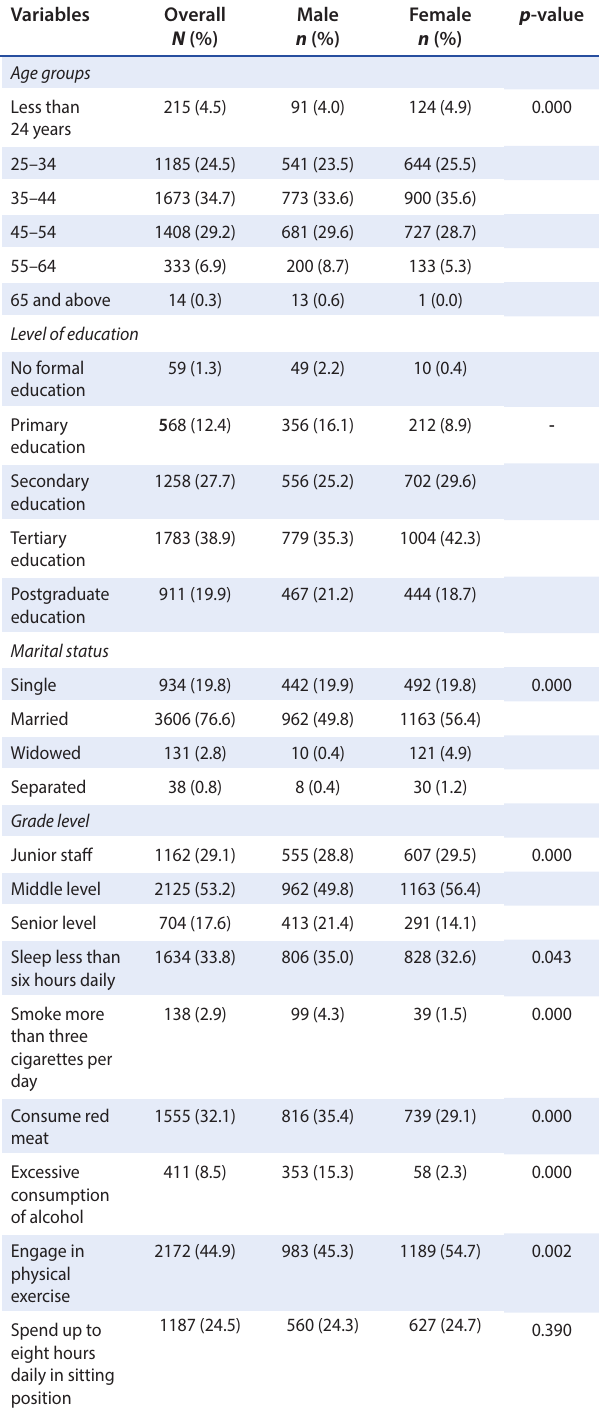
Table 1: Baseline characteristics of the